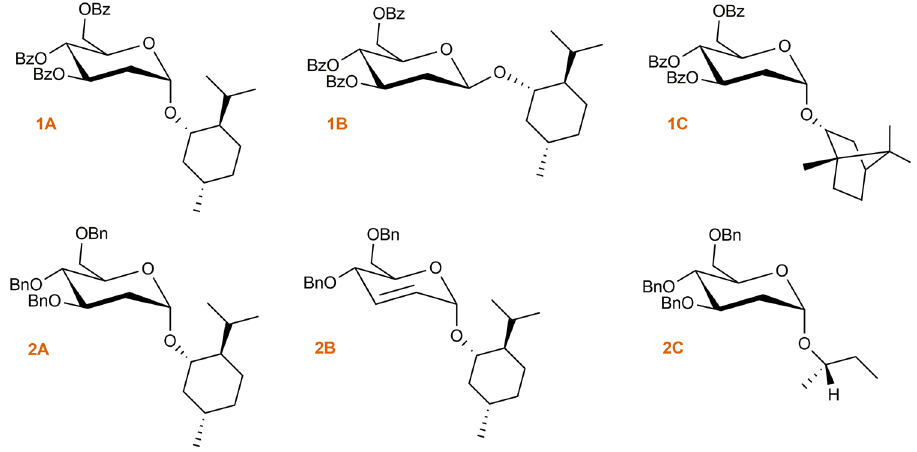
Figure 4. Received O-glycosides 1A , 1B , 1C , 2A , 2B and 2C.